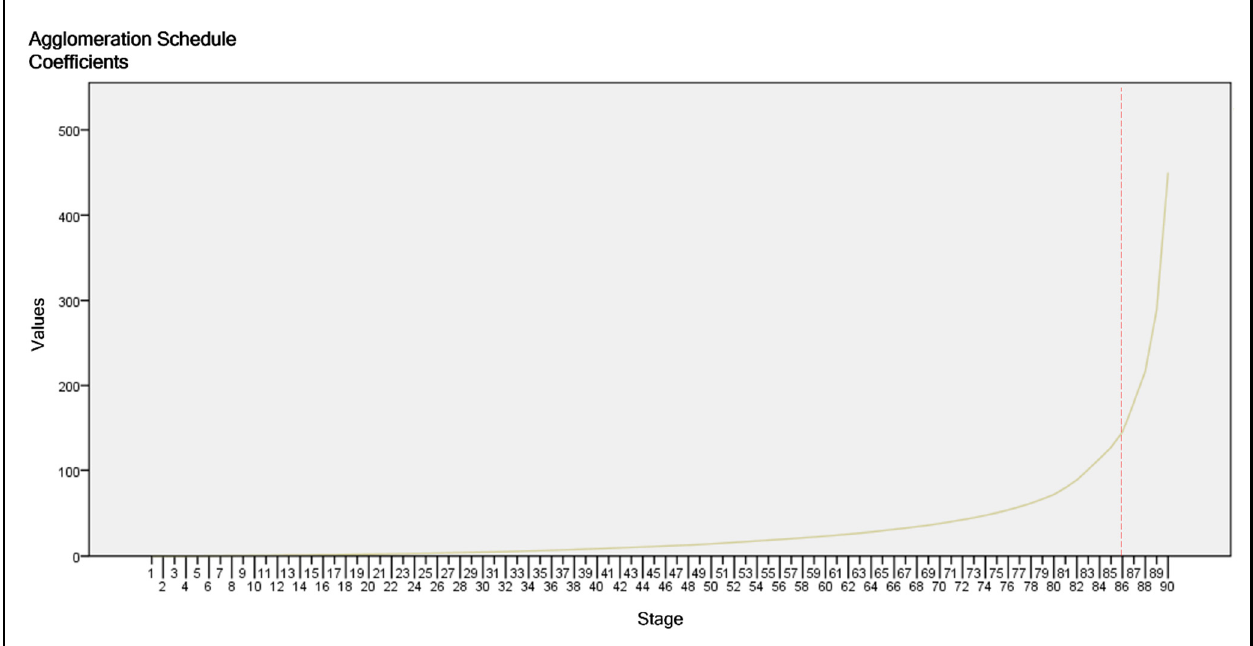
Figure A1. Agglomeration coefficients for the hierarchical clustering (Ward with Euclidean distances). The red line indicates the cut-off point (with 5 clusters, stage 86).